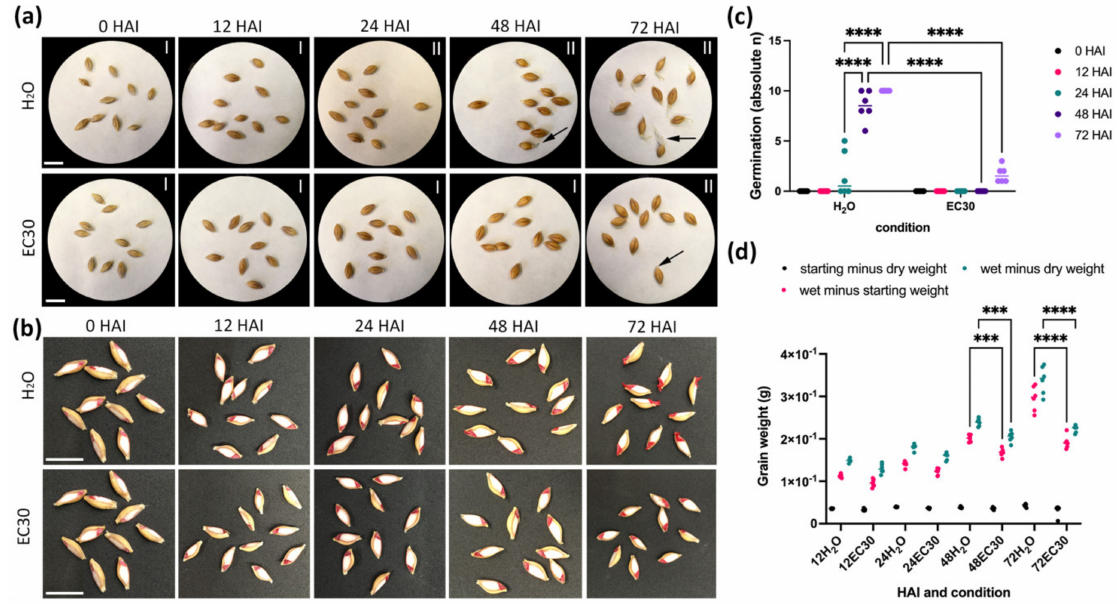
Figure 2. Physiological characterization of germinated GP grains in H 2 O versus EC30 treatment. ( a , b ) Physiological and ( c , d ) quantitative characterization of germinated grains soaked in H 2 O versus EC30 treatments. The germination phases I and II are indicated describing germination sensu stricto . ( a ) Physiological characterization of the germination process in H 2 O versus EC30 treatment. Arrows point to the emerged radicle. ( b ) Viability staining using 1% TCC (2,3,5-Triphenyltetrazolium chloride (TTC) of the germinated grains. ( c ) The germination process was significantly different between 48 and 72 HAI in H 2 O compared to EC30. ( d ) The starting, wet, and dry weight during germination in H 2 O and EC30. The greatest water uptake was at 72 HAI when grains were germinated in H 2 O. Note that in ( b ), the 0 HAI picture is the same for H 2 O and EC30. EC30 = EC30 mS/cm (2 g NaCl in 100 mL tap water). Statistical analyses: two-way ANOVA; significance is indicated with *** ( p -value ≤ 0.0002) and **** ( p -values ≤ 0.0001); scale = 1